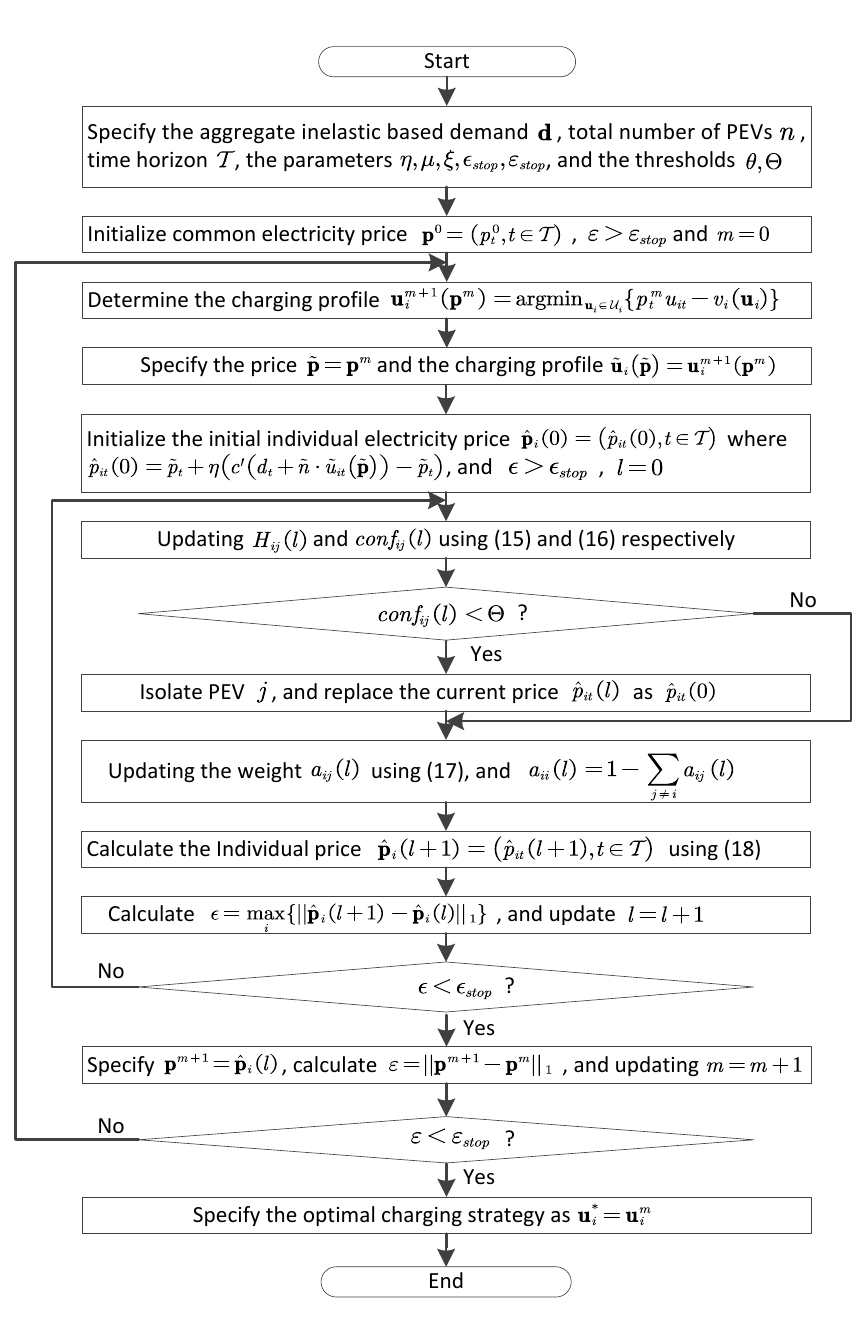
Figure 5. The flowchart of resilient distributed coordination of PEV